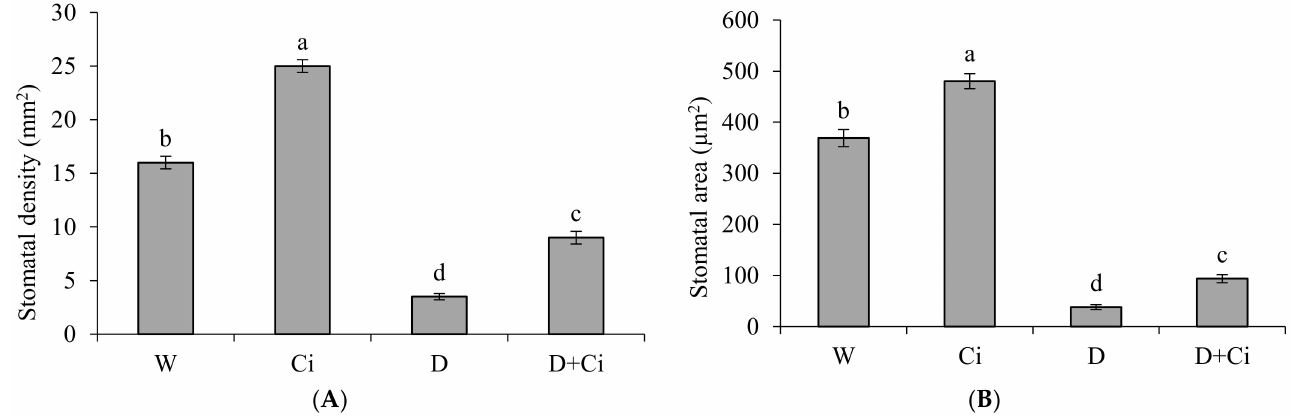
Figure 4. ( A ) Stomatal density and ( B ) stomatal area of Calendula officinalis after foliar application of chitosan (7.5 mg L − 1 ) weekly at 100% and 60% FC. Letters above the bars represent significant differences at p < 0.05 according to LSD test. W, normal conditions (100% FC); W + Ci, chitosan under normal conditions; D, drought stress without chitosan (60% FC); D + Ci, drought stress with chitosan (each mean consists of 3